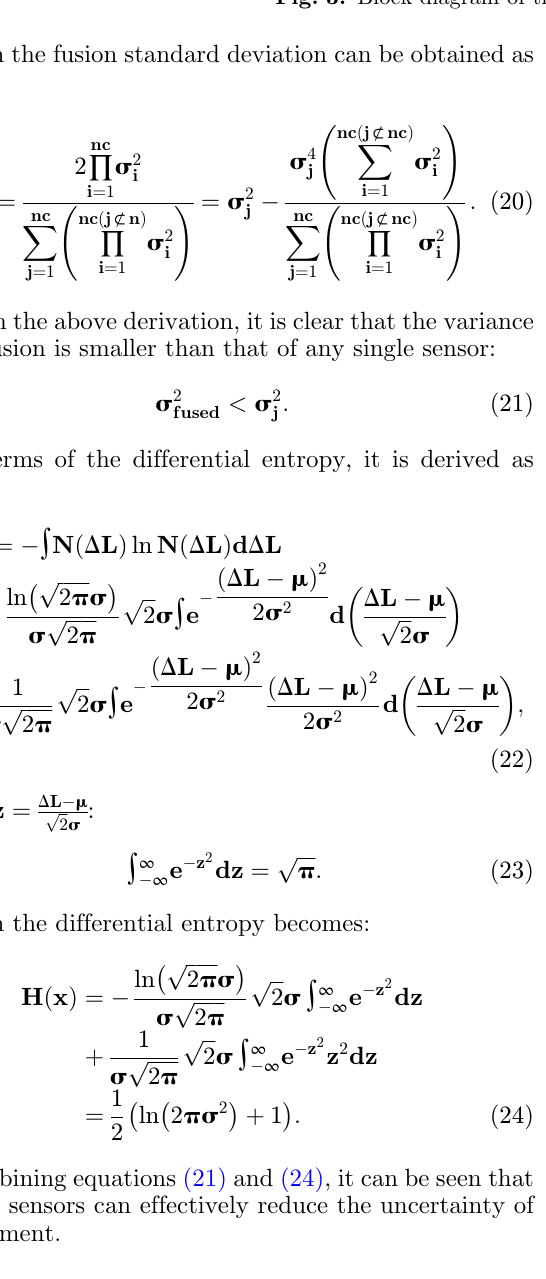
Fig. 3. Block diagram of the neural